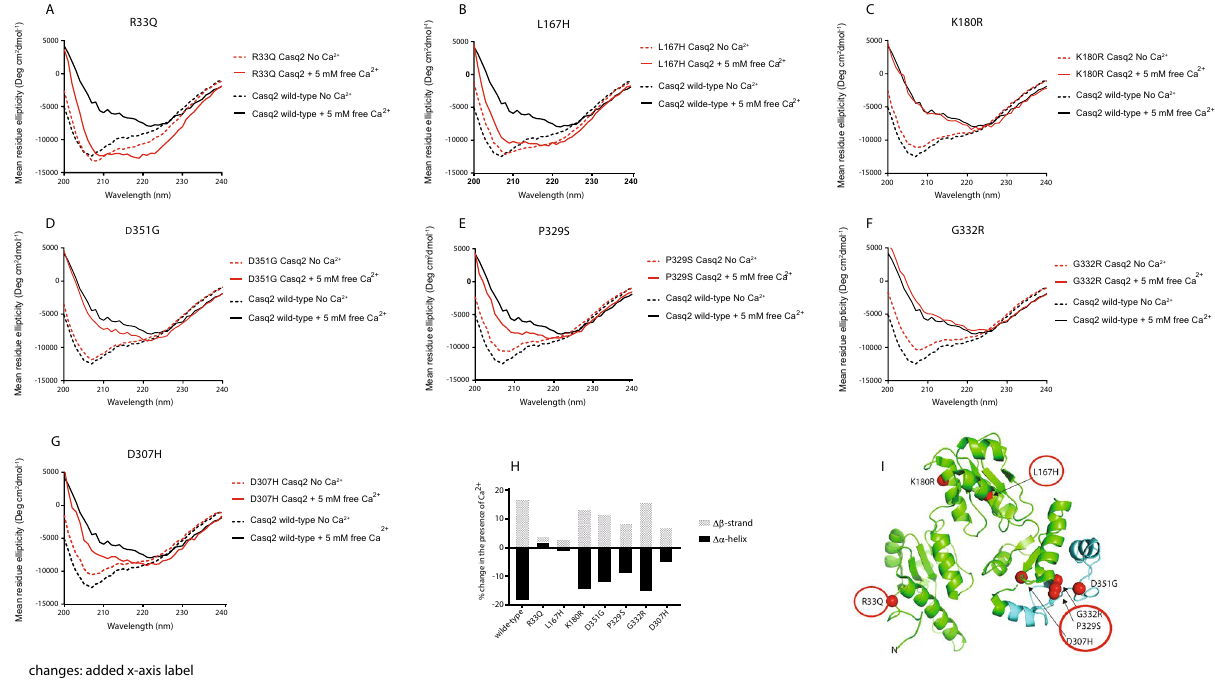
Figure 4. CD analysis of Casq2 mutants. ( A – G ) CD analysis of Casq2 mutants (red solid line) and wild-type Casq2 (black solid line). CD analysis in the presence of 5 mM Ca 2+ is indicted by black dotted lines for wild-type Casq2 and by red dotted lines for Casq2 mutants. ( H ) Change in % of α-helix and β-strand content with the absence or presence of Ca 2+ for wild-type Casq2 and each Casq2 mutant. Negative and positive values indicate a loss or gain of secondary structure content, respectively. ( I ) Three-dimensional structure of human Casq2 (2VAF). Red circles depict the location of mutations with altered CD spectrum.